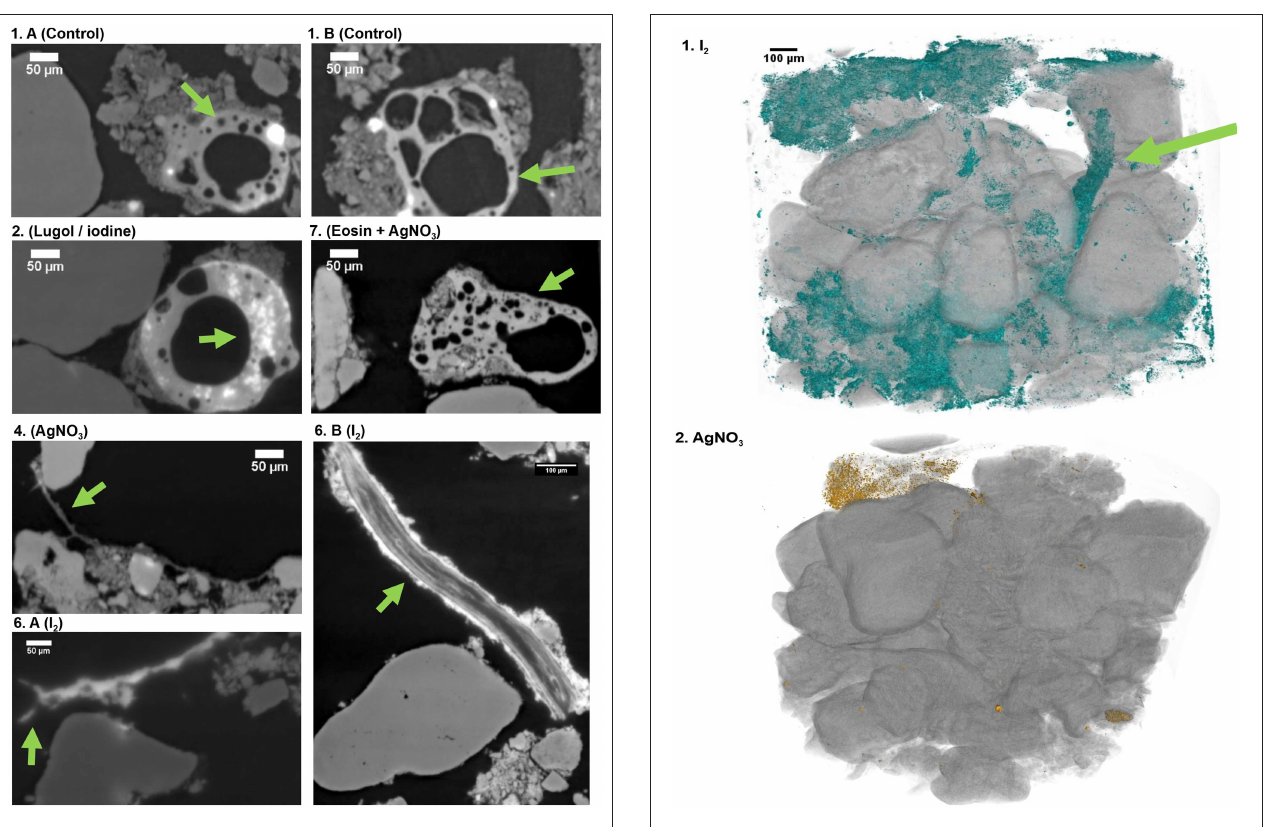
FIGURE 2 | Reconstruction images (X-Z plane) of the synchrotron based X-ray tomographies (16 keV and voxel size 0.438 µ m) of the soil samples: (1A,B) control, (2) stained with Lugol, (4) AgNO 3 , (6) A-B I 2 , and (7) Eosin + AgNO 3 . Green arrows indicate details that are mentioned in the text.